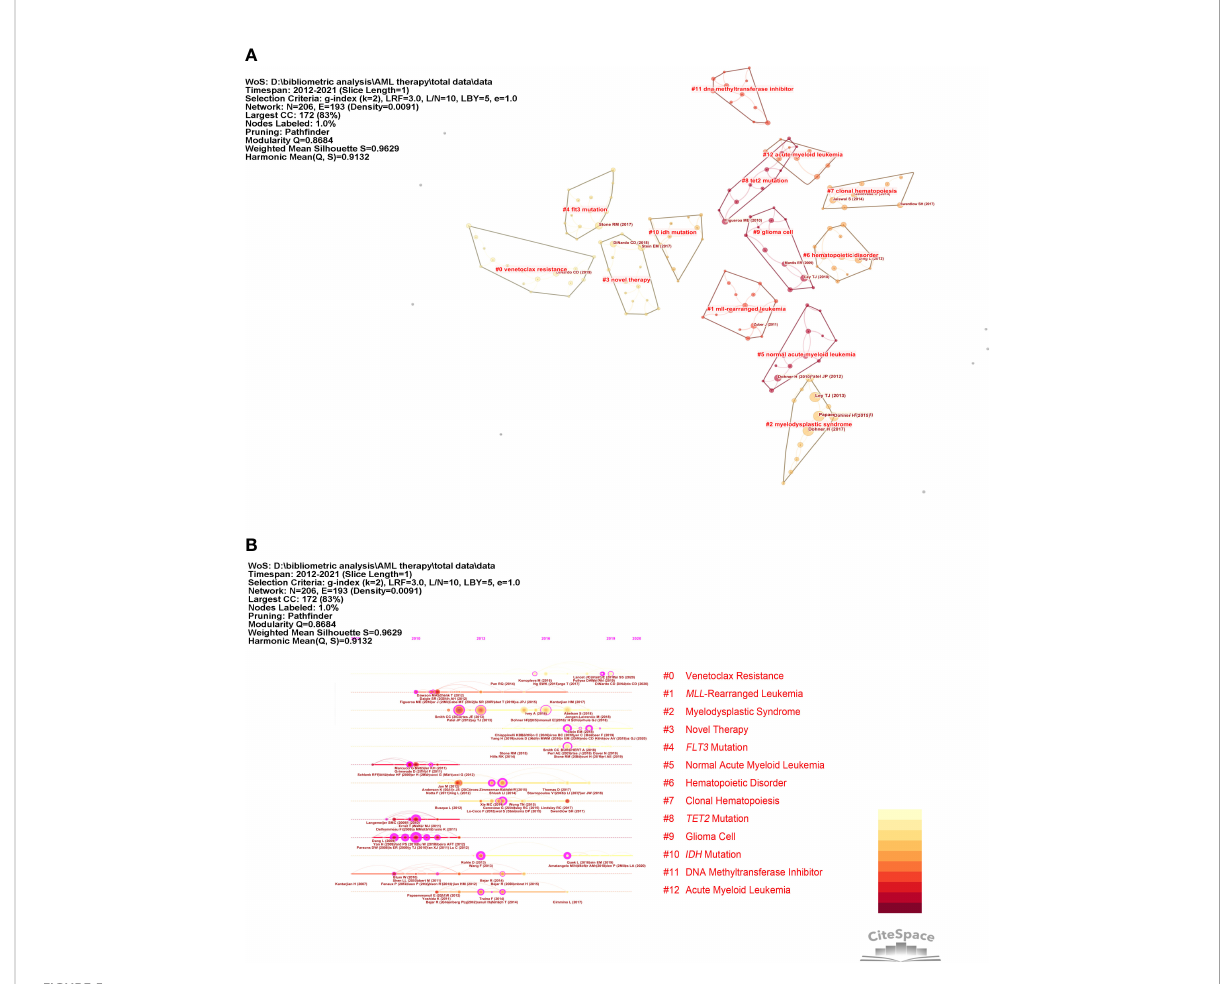
FIGURE 5 Co-citation network and timeline view of references. (A) Reference co-citation network. The circles in Figure 4A indicate references. (B) Timeline view of references. The circular nodes on the line represent the three most cited references in this time